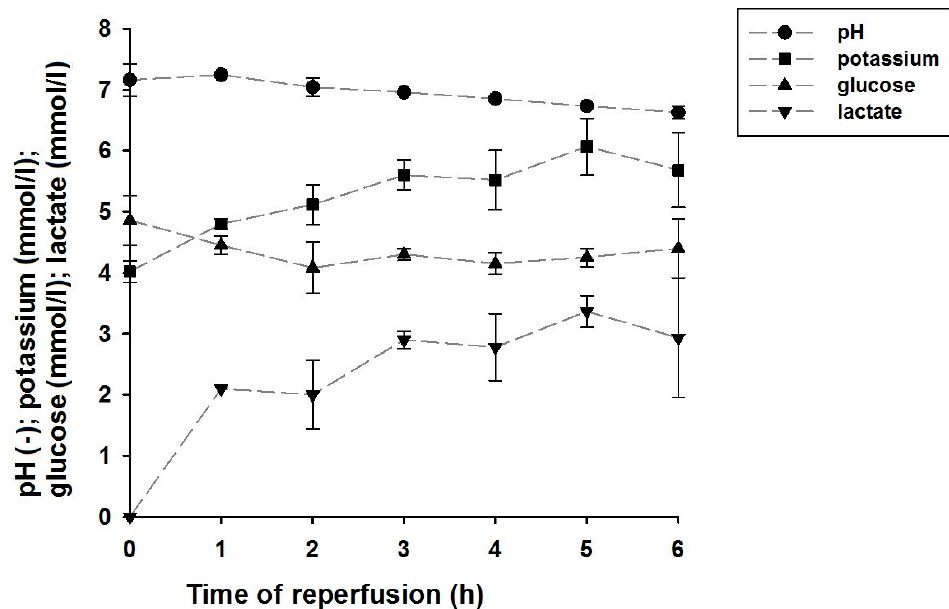
Figure 5. Blood gas analysis from the perfusate before EP (t = 0 h) and from the venous perfusate collected from muscles perfused with modified hydroxyethyl starch solution. Values were recorded at t = 0 h, measured with pure perfusate; all subsequent values were measured in samples collected from the venous drainage directly after the muscle’s cannulated vein. Dotted lines are included for better identification of the time course of data points.